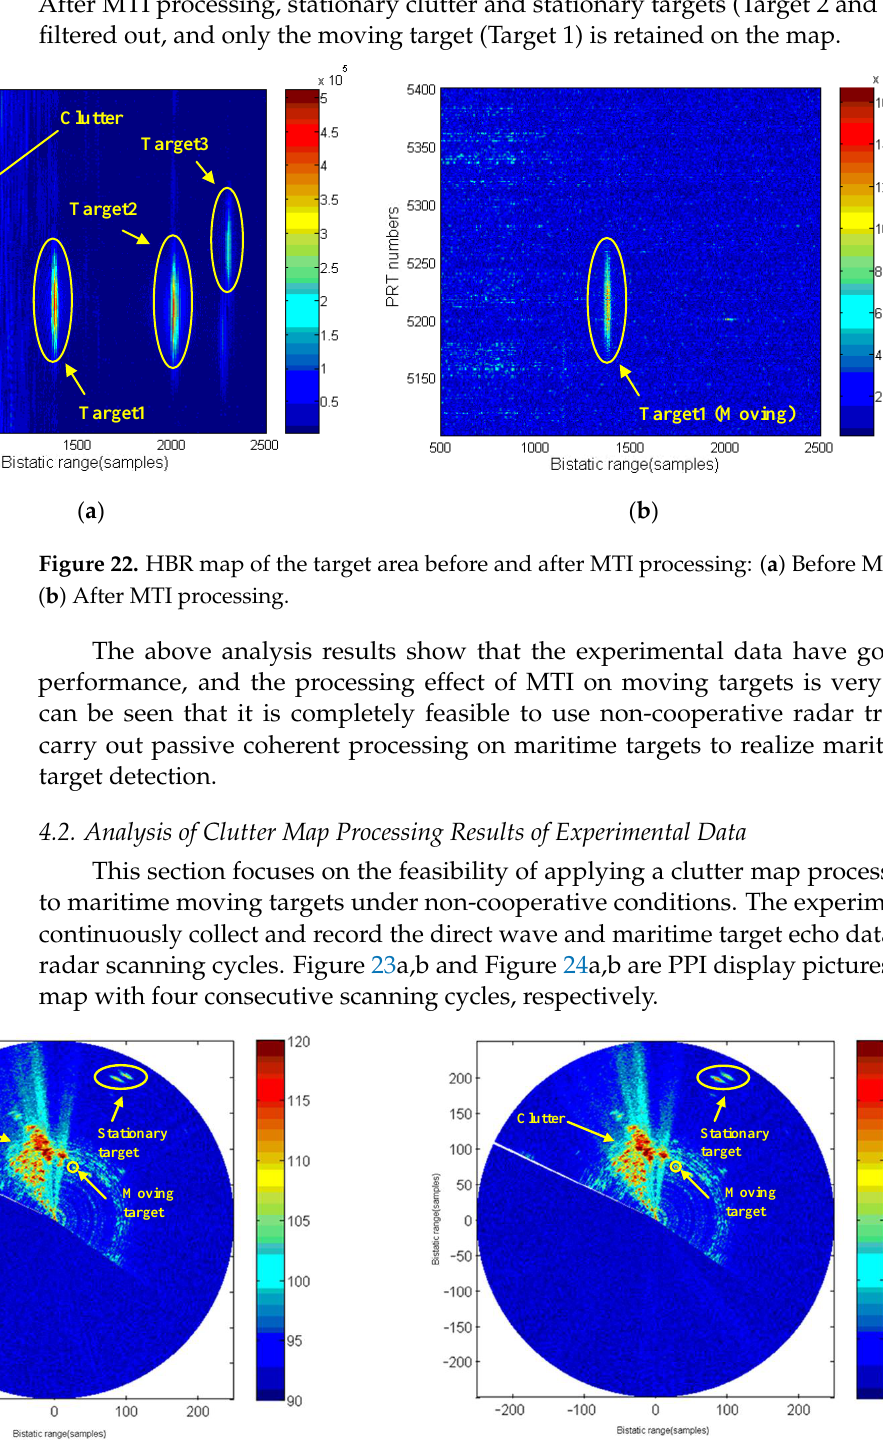
Figure 21. HBR map after m agnification of the target area: ( a ) Range-azimuth map ; ( b ) Range-Doppler (R-D) map .